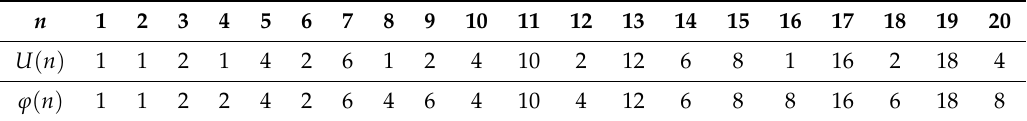
Table 1. Values of U ( n ) and ϕ ( n ) ( 1 ≤ n ≤ 20 )